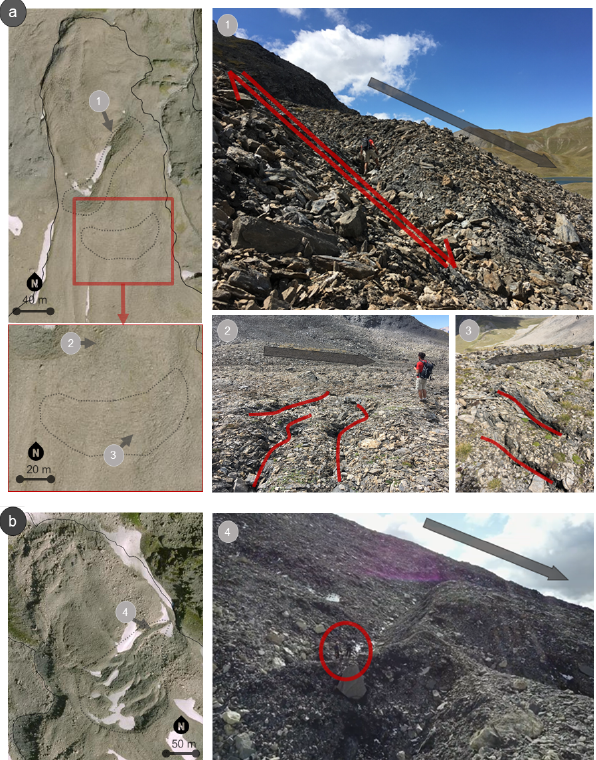
Figure 2. Examples of surface disturbances observable in the avail- able orthoimages of 2013 in comparison to field observations on (a) Roc Noir (Serrano, 2017) and (b) Pierre Brune (Echelard, 2014) destabilized rock glaciers. The black arrows indicate the rock glacier displacement direction. A scarp (1) and cracks (2, 3) have been observed on the Roc Noir rock glacier. Large crevasses (4) can be seen on the Pierre Brune rock glacier. The dotted black lines in- dicate how the surface disturbances were mapped on these orthoim- ages.